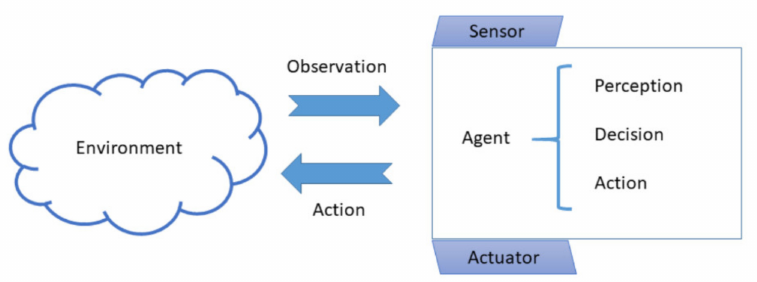
Figure 2. Conceptualizing Cyber-Physical System (CPS) components as agents encapsulating a behavior.